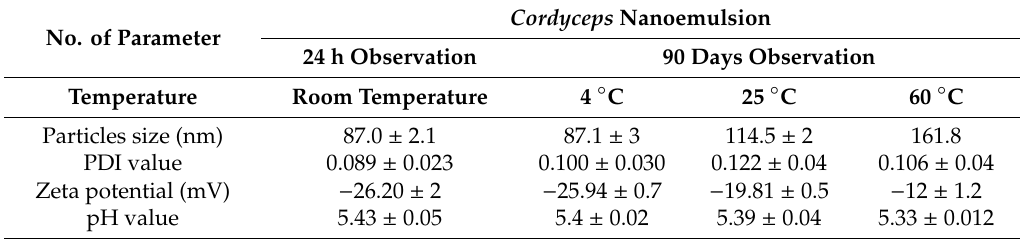
Table 2. Cordyceps nanoemulsion stability test after 90 days observations.